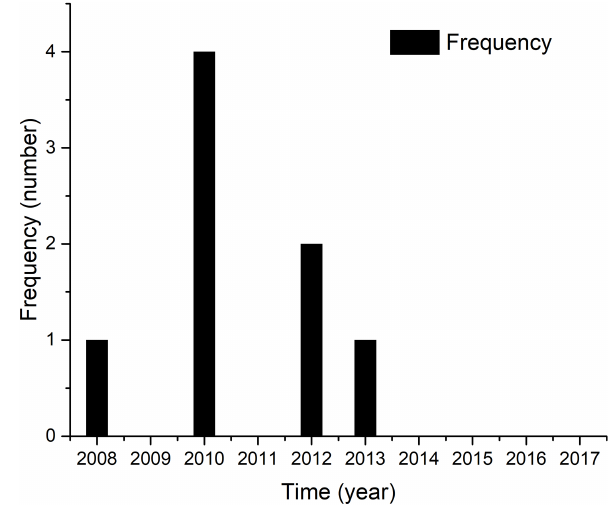
Figure 5. The frequency of debris flow events in Wenjia gully from 2008 to